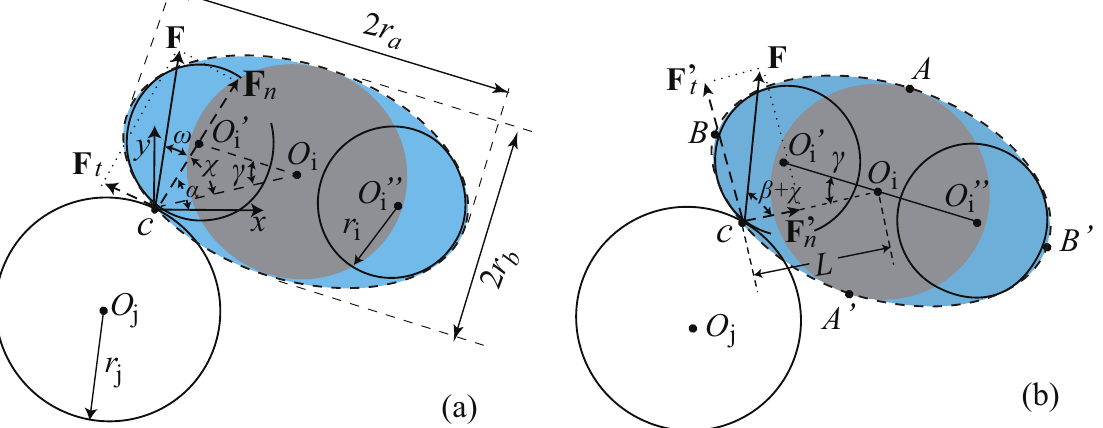
Figure 1. Sketch of a collision with one elliptical particle. The elliptical particle is composed of three circular elements and c is the contact point. ( a ) Normal force | F n | and tangential force | F t | are obtained from the binary collision of circular particles O i and O j ; ( b ) the total force, F = F (cid:48) n + F (cid:48) t , is decomposed into F (cid:48) n and F (cid:48) t to calculate the motion of the elliptical particle O i